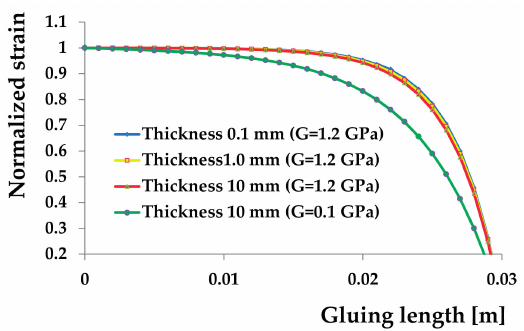
Figure 5. Effects of the glue thickness on the strain